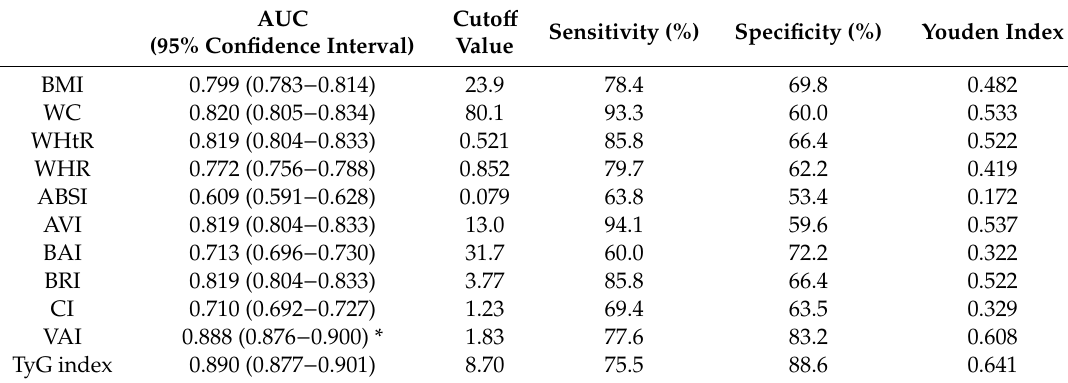
Table 4. Area under curve (AUC), cuto ff value, Youden index, sensitivity and specificity of 11 obesity-related indices for predicting MetS in